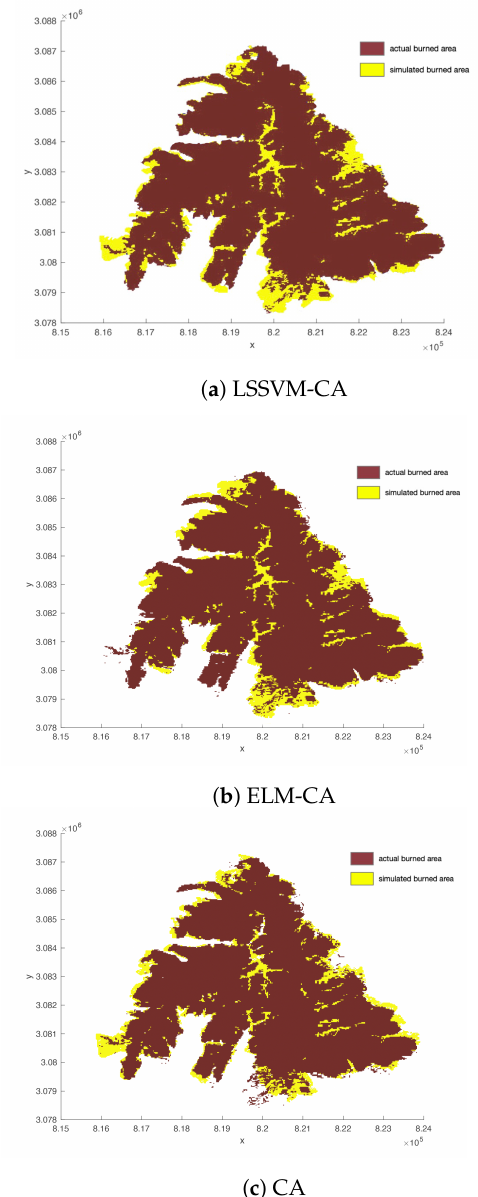
Figure 7. Comparison between the actual fire area and the simulation